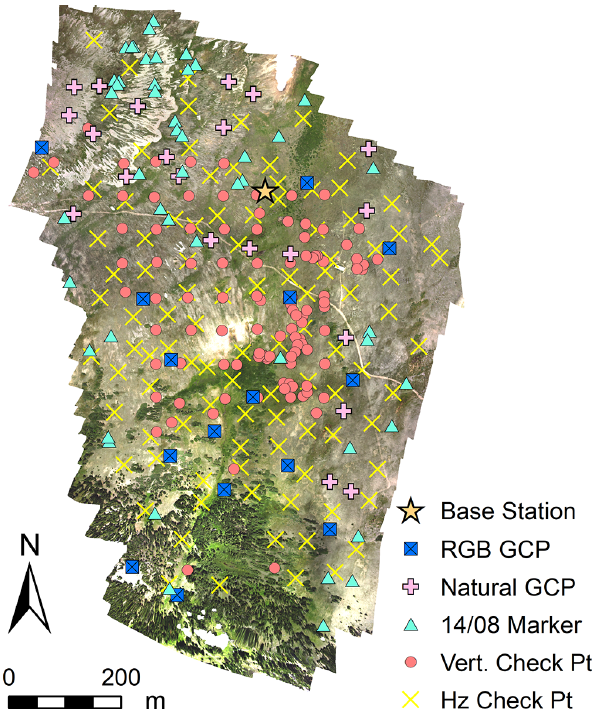
Figure 3. Location of the local base station, all GCPs, and check points used in SfM processing and error